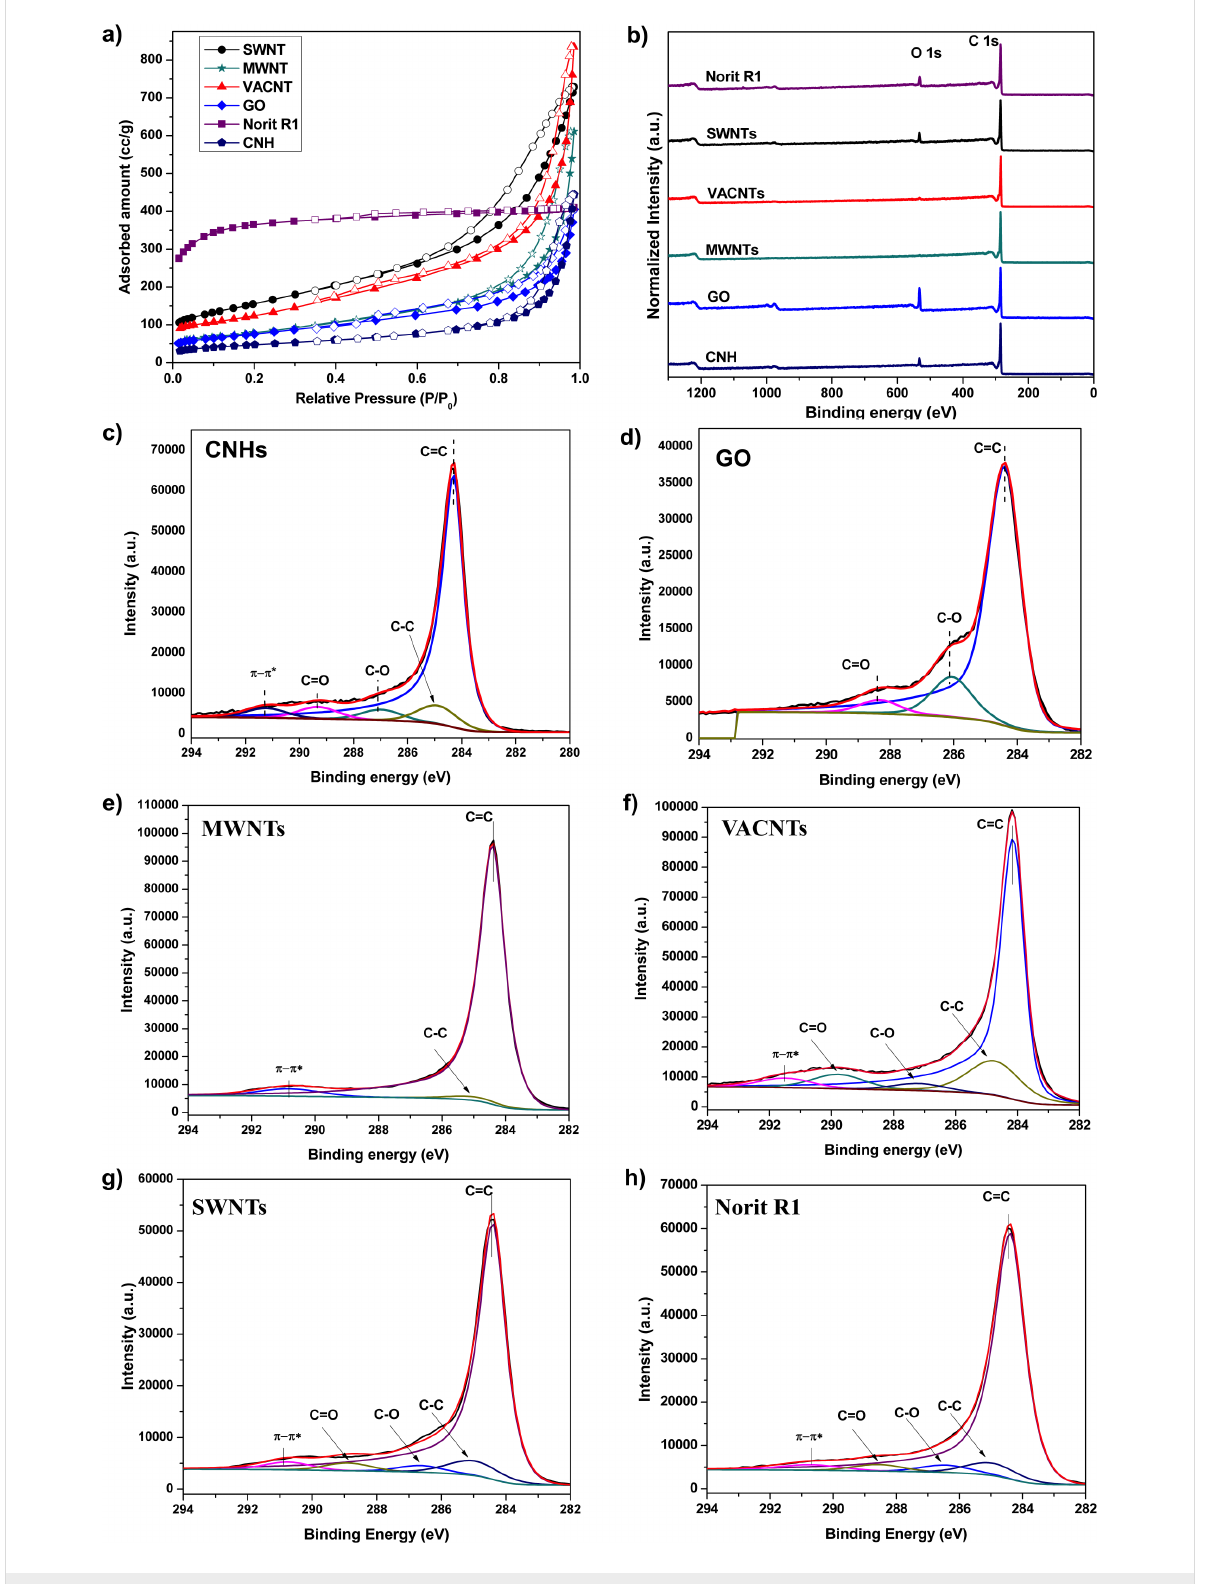
Figure 4: a) N 2 adsorption isotherm at 77 K and b) survey spectra of the six different carbon adsorbents studied. C 1s spectrum of c) CNHs, d) GO [12] e) MWNTs, f) VACNTs, g) SWNTs and h) Norit R1